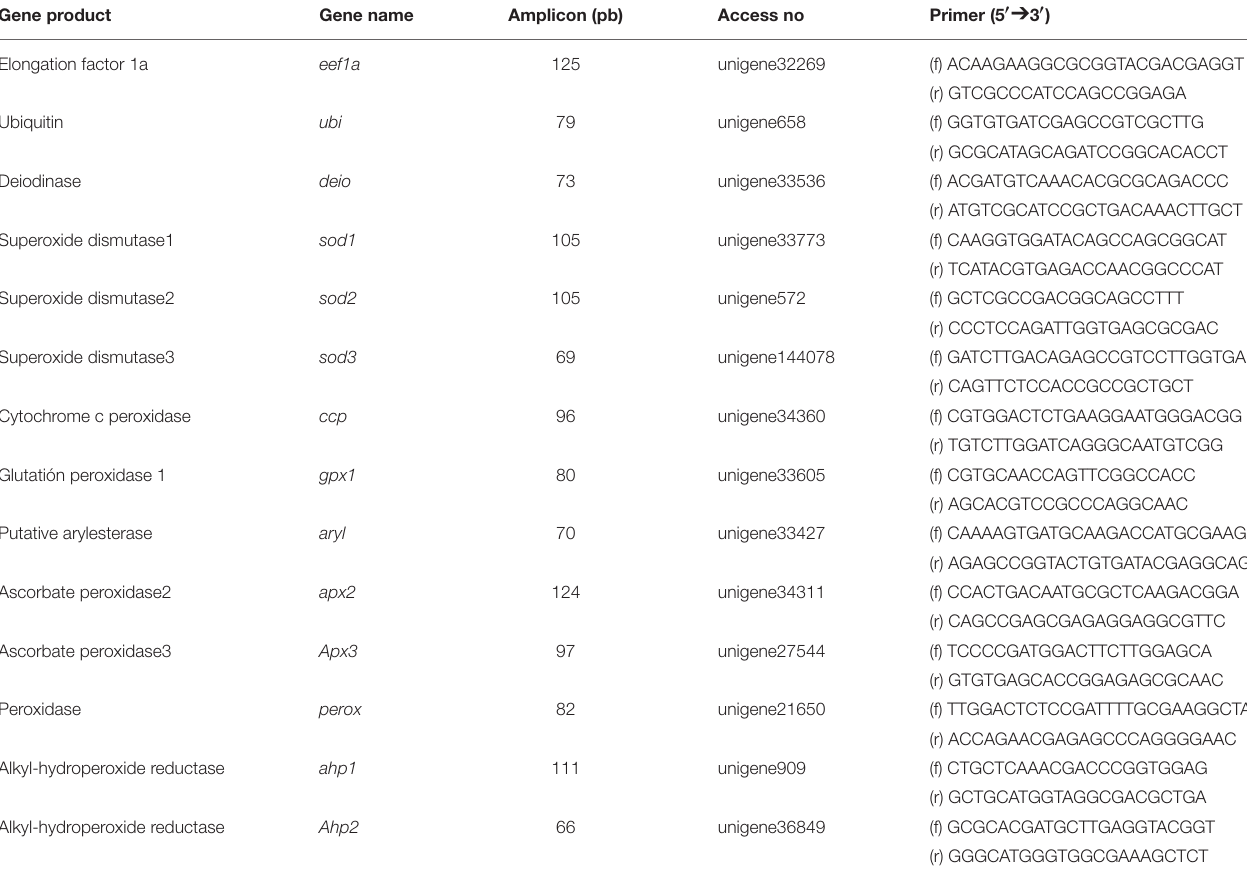
TABLE 1 | Primers used for qPCR